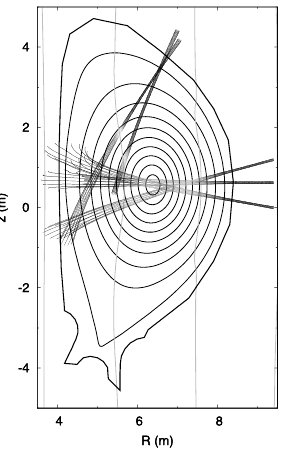
Fig. 2. Propagating 170 GHz beams for UL and EL, with harmonic resonance locations (n=3,4 inside the plasma) .